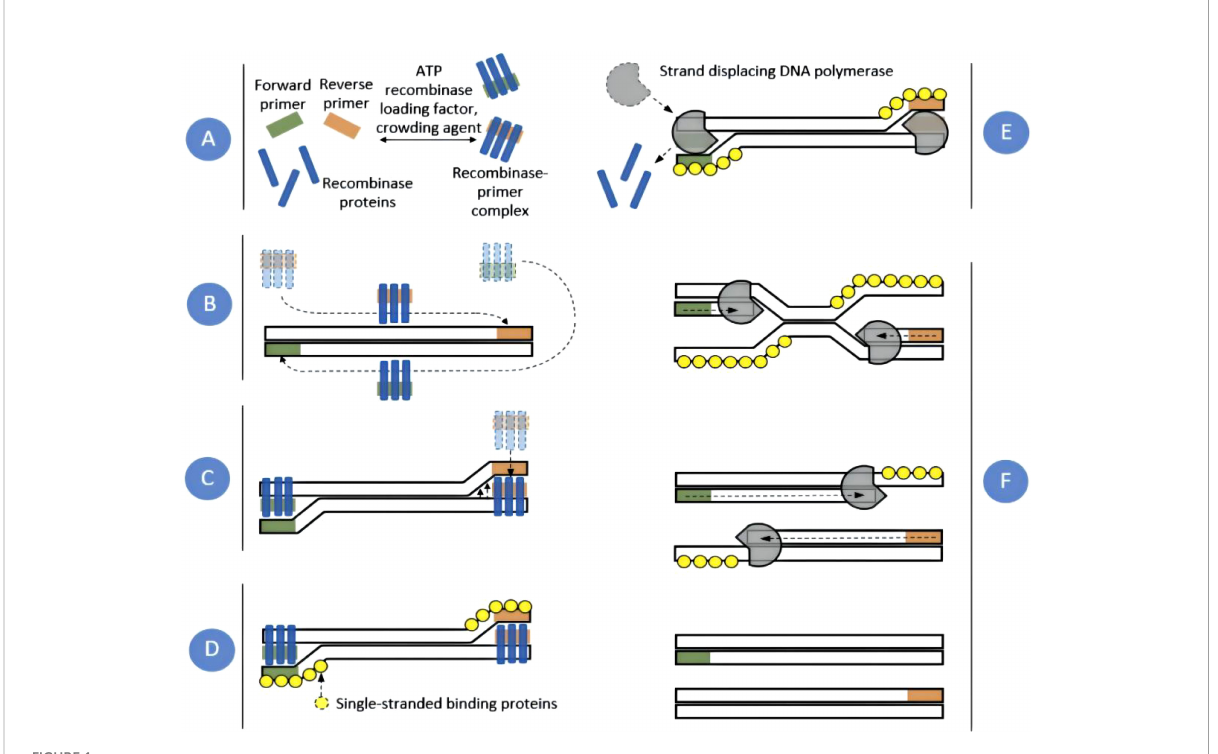
FIGURE 1 RPA ampli fi cation scheme. Recombinase proteins formed complexes with each primer (A) , which scanned DNA for homologous sequences (B) . The primers were then inserted at the cognate site by the strand-displacement activity of the recombinase (C) and single-stranded binding proteins stabilized the displaced DNA chain (D) . The recombinase then disassembled leaving the 3` end of the primers accessible to a strand displacing DNA polymerase (E) , which elongated the primer (F) . Exponential ampli fi cation was achieved by cyclic repetition of this process (Lobato and O ’ Sullivan,